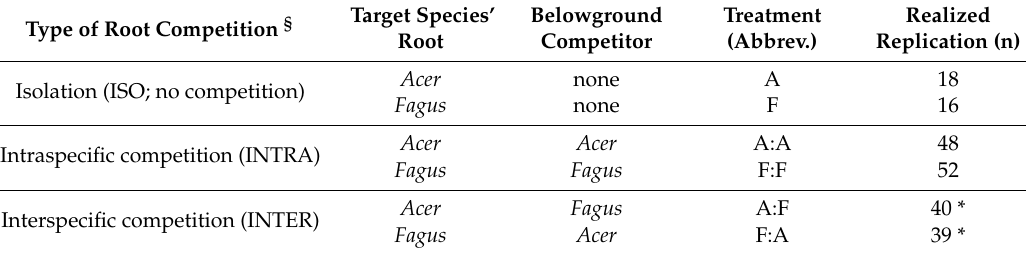
Table 1. Experimental set-up with three competitive situations belowground (i.e., isolation, intra- and interspecific competition) for a nutrient-rich spot by roots of two species, Fagus sylvatica (F) and Acer pseudoplatanus (A), resulting in six treatments (three per species). A:F and F:A originate essentially from the same competition chambers, but a distinction is made whether Acer (A:F) or Fagus (F:A) is considered the ‘target species’ (vs. competitor). Abbreviations of treatments are used throughout the manuscript; the number of realized replicates are given.